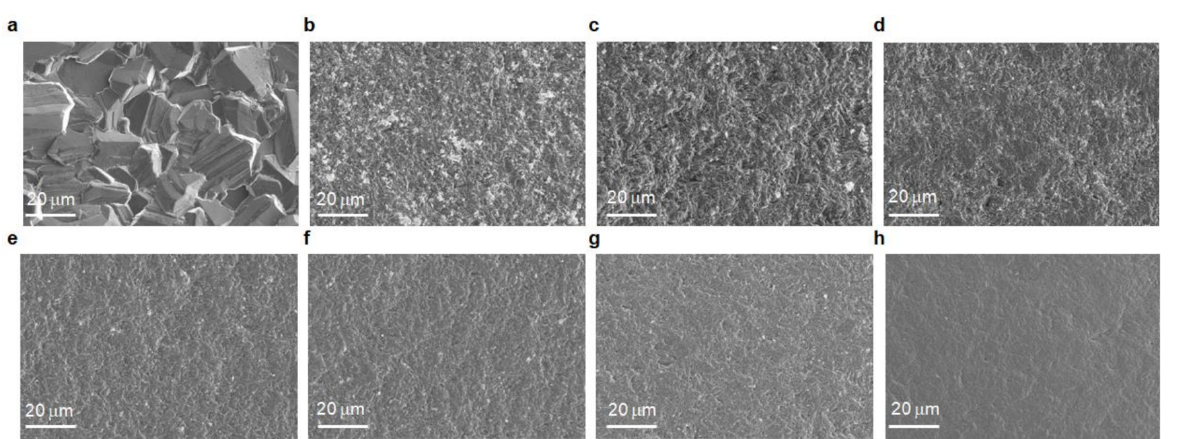
Figure 2. SEM micrographs of as grown and ground diamond films, the films ground by different combinations of abrasive particles. ( a )As-grown; ( b ) W40; ( c ) W40 to W20; ( d ) W10; ( e ) W20; ( f ) W40 to W10; ( g ) W20 to W10; ( h ) W40 to W20 to W10. W is the diameter of abrasive particles, W40, W20, W10 represent the diameter of diamond abrasive in grinding is 40 µ m, 20 µ m, 10 µ m, respectively. The ( b , d , e ) mean that only one grain size abrasive is used; ( c , f , g ) mean that two kinds of abrasives have been used successively; ( h ) means that abrasives with three particle sizes are used in